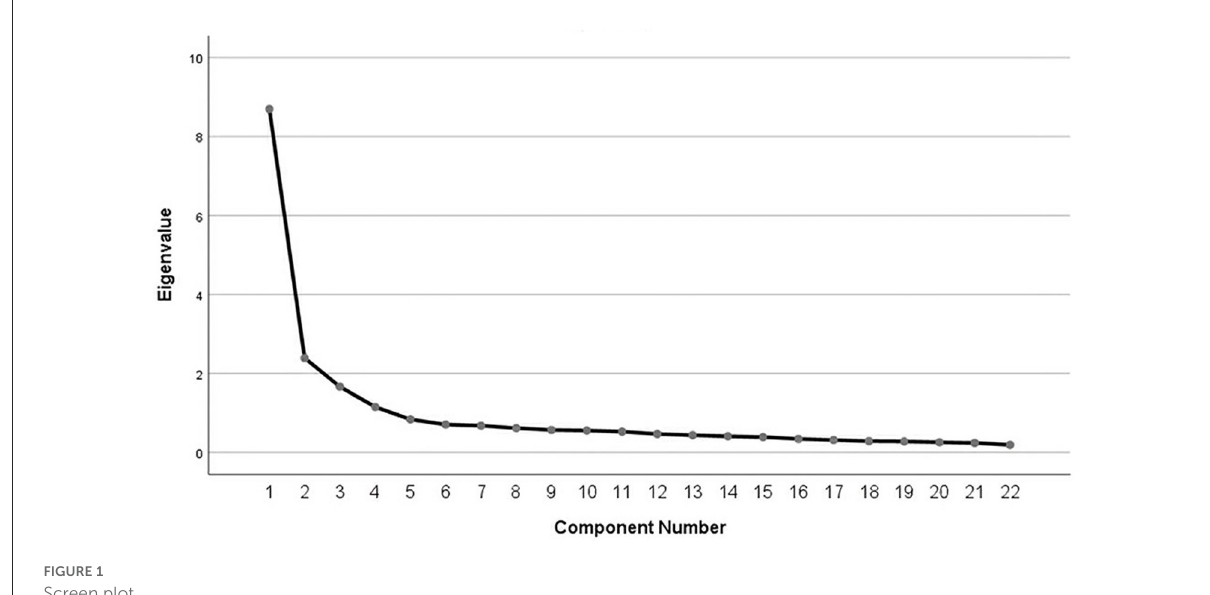
FIGURE1 Screen plot.